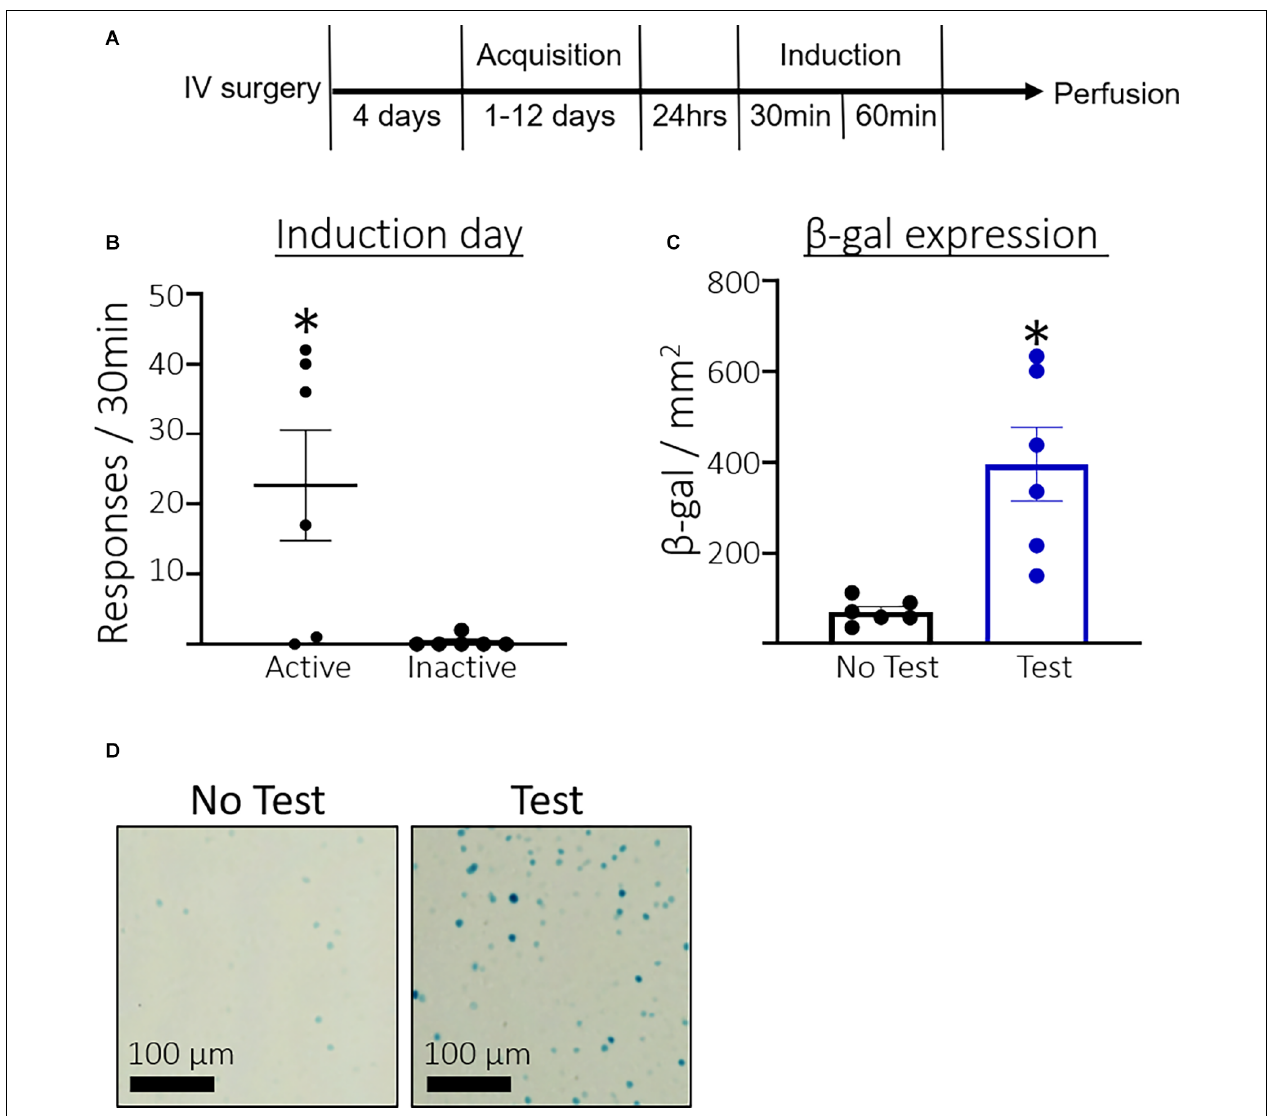
FIGURE 1 | Experiment 1: Prelimbic cortex (PL) β -galactosidase expression after acquisition of cocaine seeking. (A) Timeline showing the behavioral procedure. We implanted jugular catheters and allowed 4 days for rats to recover. We trained rats to lever press for infusions of cocaine in 3 h daily sessions for between 1 and 12 days until they reached acquisition criteria of ≥ 30 active lever presses and ≥ 70% of total lever responses on the active lever. We tested rats 24 h after acquisition in a 30 min non-reinforcing cocaine seeking induction session. Rats were sacrificed 60 min after the session ended and euthanized for β -gal quantification. (B) The number of total active and inactive lever responses in the induction session. (C) The number of β -gal positive nuclei per mm 2 in the PL. (D) Representative images showing β -gal labeling in the PL. Data are presented as mean ± SEM ( n = 6 per group). ∗ p < 0.05 compared to home cage